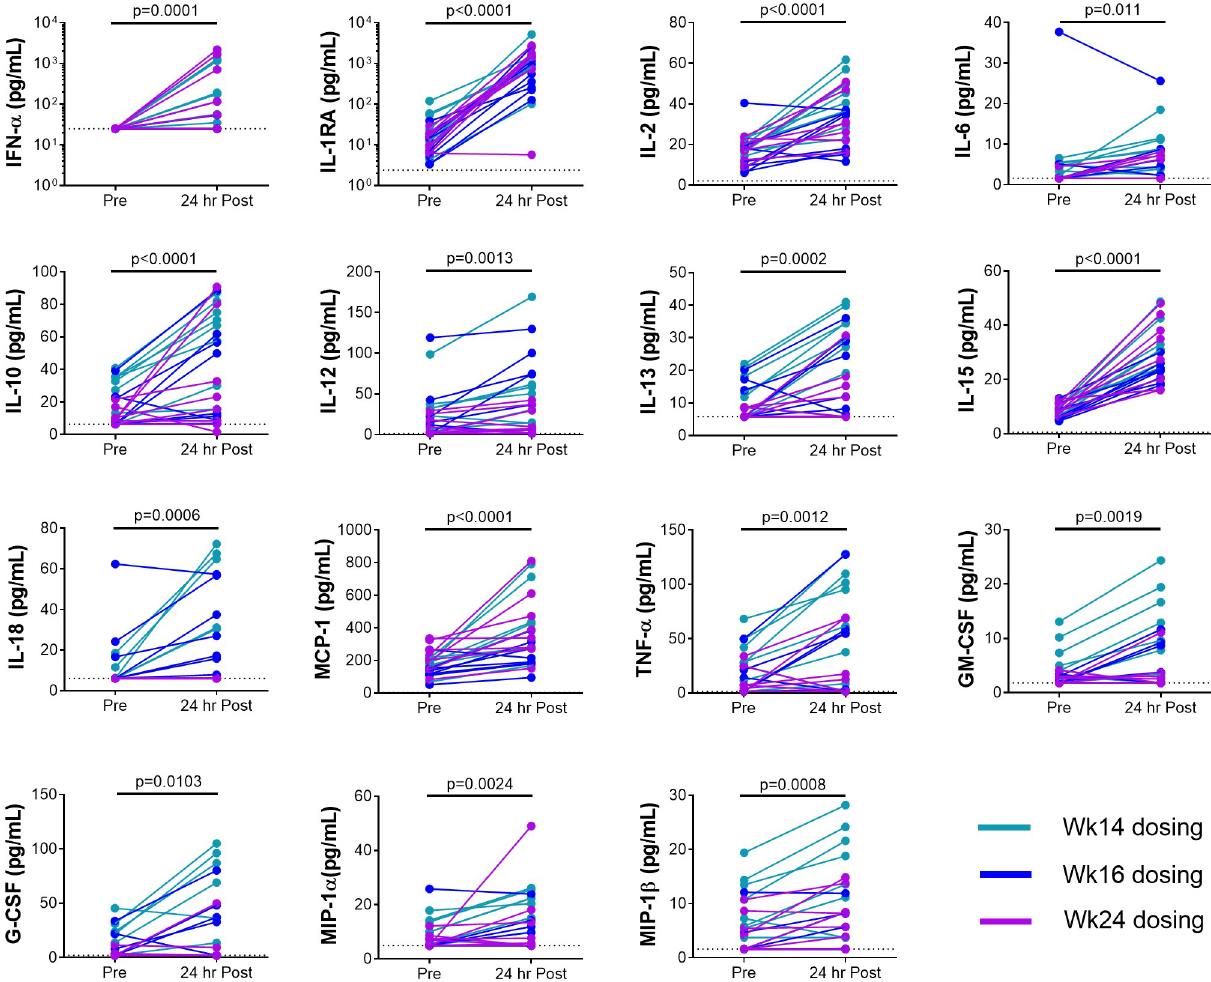
Fig 2. Plasma levels of soluble biomarkers of immune activation pre and 24 hrs post GS-986 administration. Administration of GS-986 was associated with increases in plasma levels of interferon (IFN)- α , Interleukin (IL)-1 receptor antagonist (RA), IL-2, IL-6, IL-10, IL-12, IL-13, IL-15, IL-18, monocyte chemoattractant protein (MCP)-1, tumor necrosis factor (TNF), granulocyte-macrophage colony stimulating factor (GM-CSF), G-CSF, macrophage inflammatory protein (MIP)-1 α and MIP1 β at 24 hrs post dosing. Data from three dosings (wks 14, 16 and 24) are shown. Dotted lines indicate limit of detection of respective markers. P values were derived using Wilcoxon matched-pairs signed rank